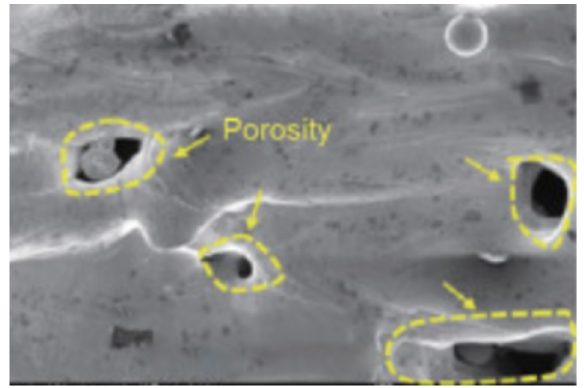
Figure 4 . Top surface morphology with laser power of 90 W [15]. Figure 4. Top surface morphology with laser power of 90 W